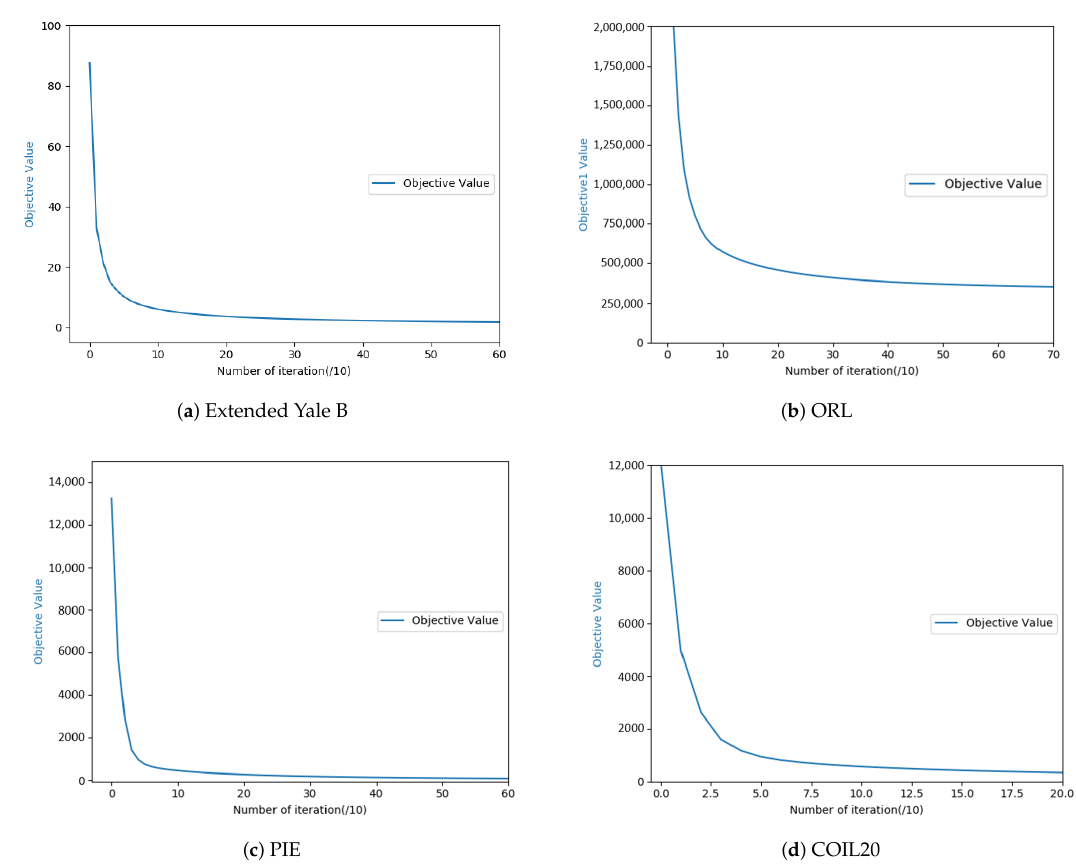
Figure 4. Convergence curve of the proposed algorithm on the four